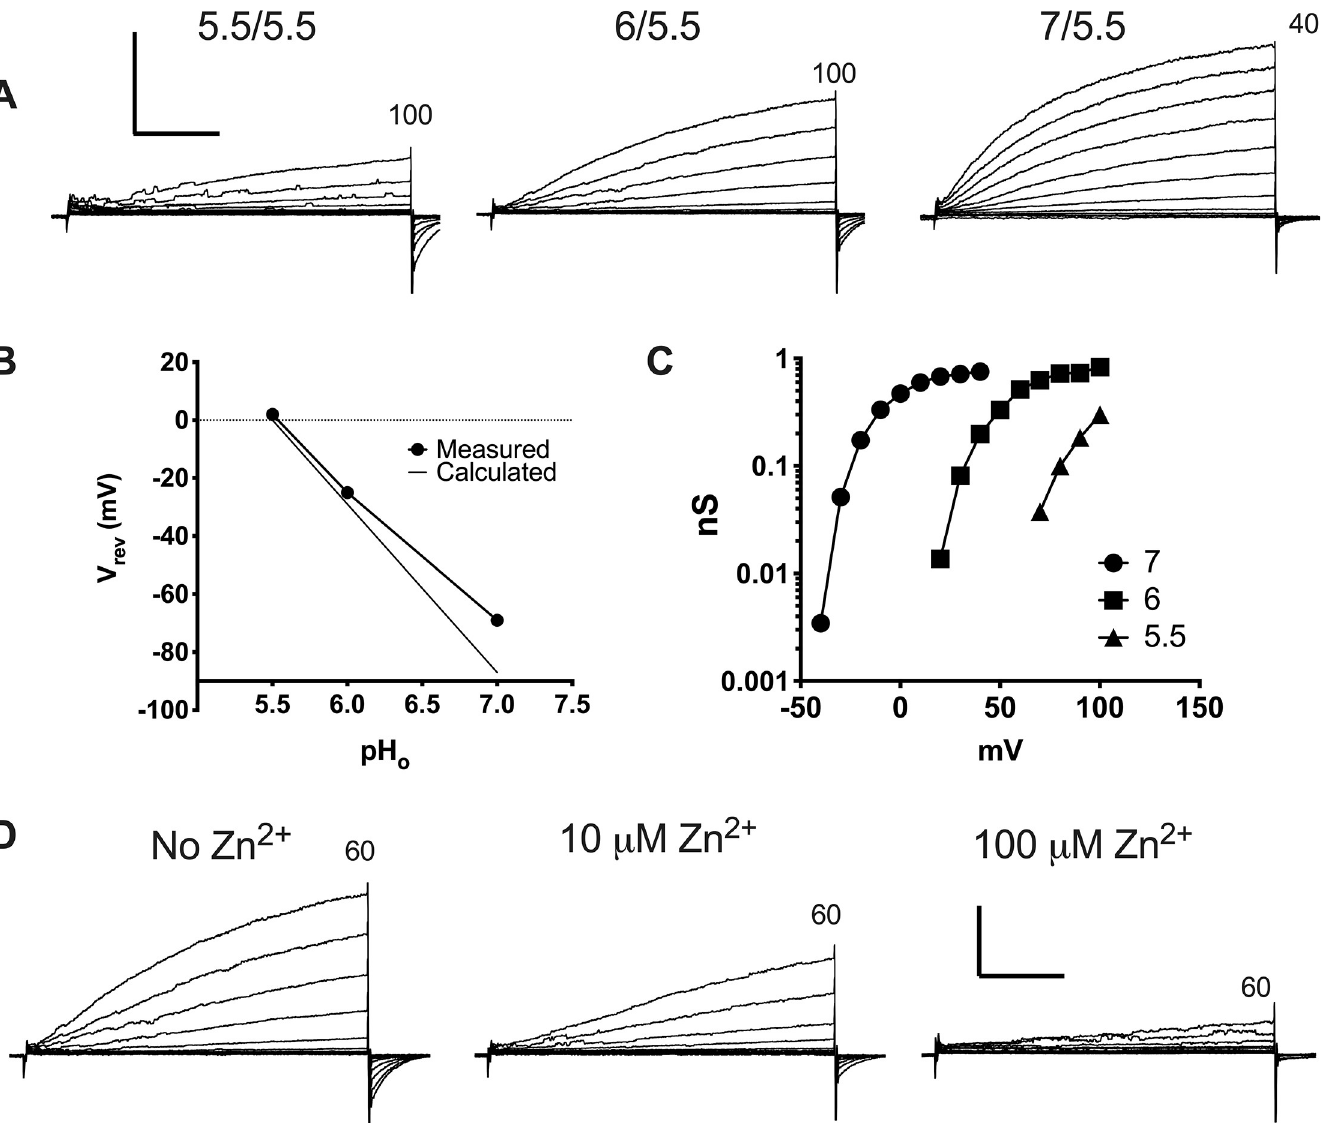
Fig 1. Proton current recorded in whole cell patch clamp configuration in an MDA-MD-231 breast cancer cell. ( A ) Three families of currents at different pH o all with a pH i of 5.5 (labeled pH o /pH i ). Voltage steps are every 10 mV, up to the numbers listed at the top of each family (in mV). The membrane was held at -40 mV (pH 6/ 5.5 and 5.5/5.5) or -60 mV (pH 7.5/5.5), and pulses were applied with an interval of 20s. The scale bar units are 100 pA and 2 s. ( B ) The reversal potential ( V rev ) of a representative cell measured at each pH o compared to the Nernst potential for protons, which assumes perfect selectivity for H + . ( C ) Proton conductance ( g H ) voltage curves derived from the data in A using V rev measured in each solution. ( D) Three families of currents in a cell at pH 6/5.5 with different concentrations of Zn 2+ as labelled. Voltage steps are 10 mV apart up to 60 mV. The scale bar units are 50 pA and 2 s.